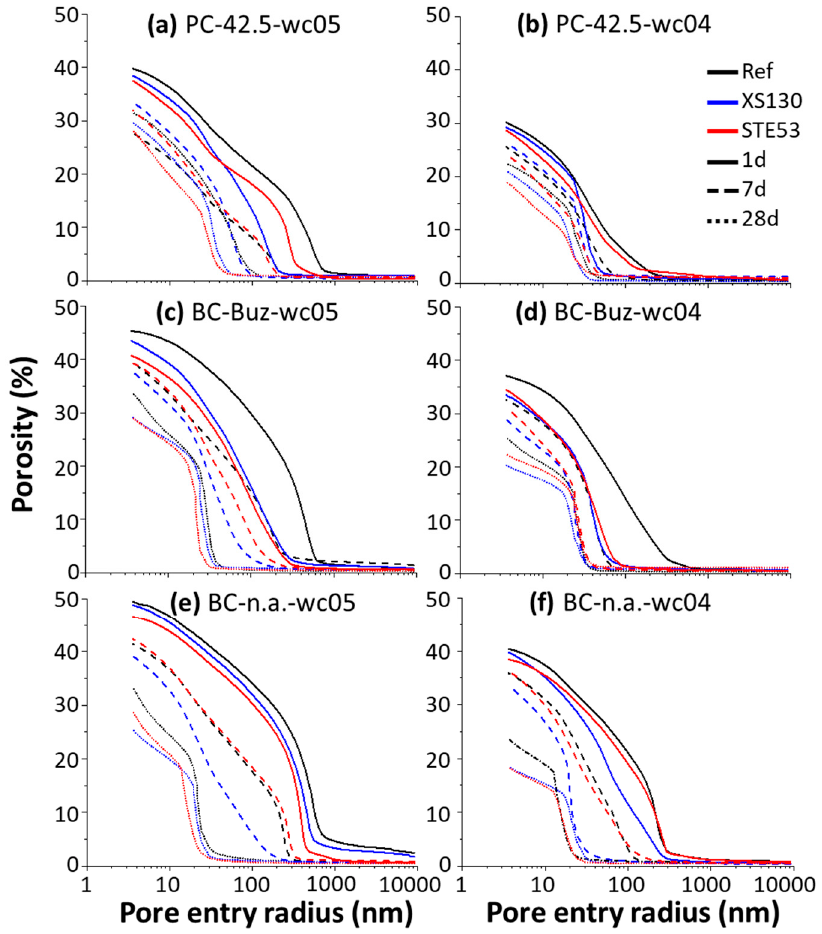
Figure 7. Mercury intrusion porosimetry cumulative porosity curves for the eighteen studied pastes at 1, 7, and 28 days of hydration. Left panels ( a , c , e ) display data for the w / c = 0.50 pastes. Right panels ( b , d , f ) show data for the w / c = 0.40 pastes.